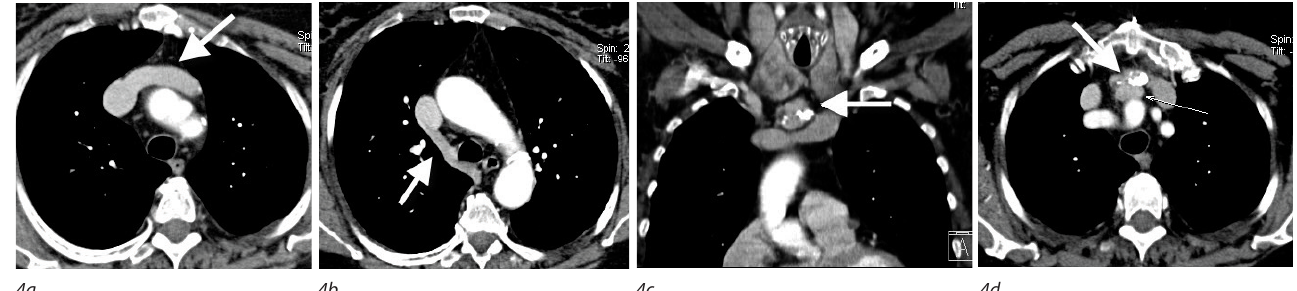
Fig. 3. Scan of the chest 60 s after contrast injection. Arrows in 3a and 3b point to the left brachiocephalic vein and azygos vein, respectively.